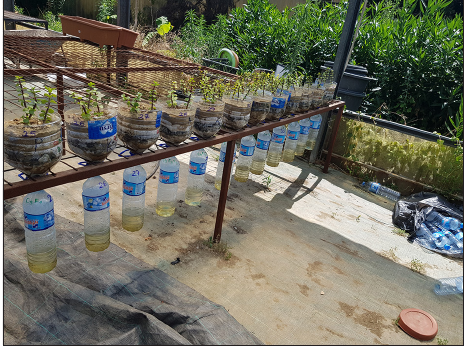
Figure 4. Drainage containers with lids